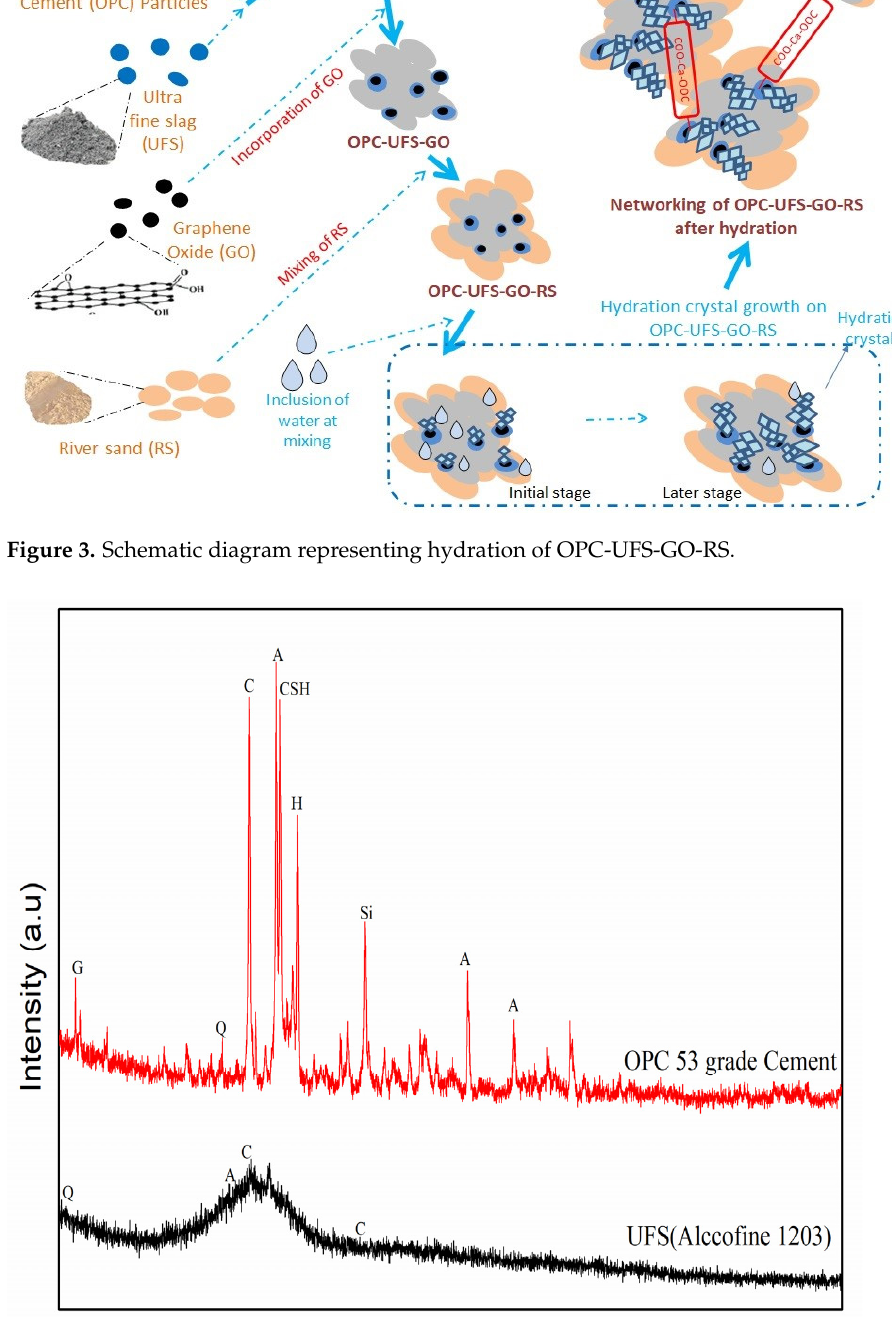
Figure 5. SEM images of GO, 53 grade OPC, and UFS (Alccofine 1203).